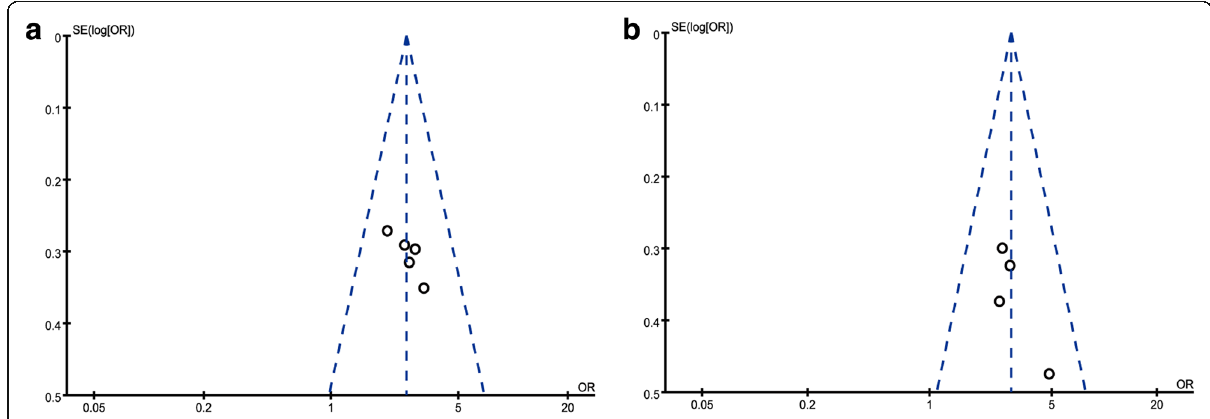
Fig. 7 Funnel plot of the meta-analysis showed no significant publication bias in responder rate. a 50% responder rates; b 75% responder rates; SE = Standard error, OR = Odds